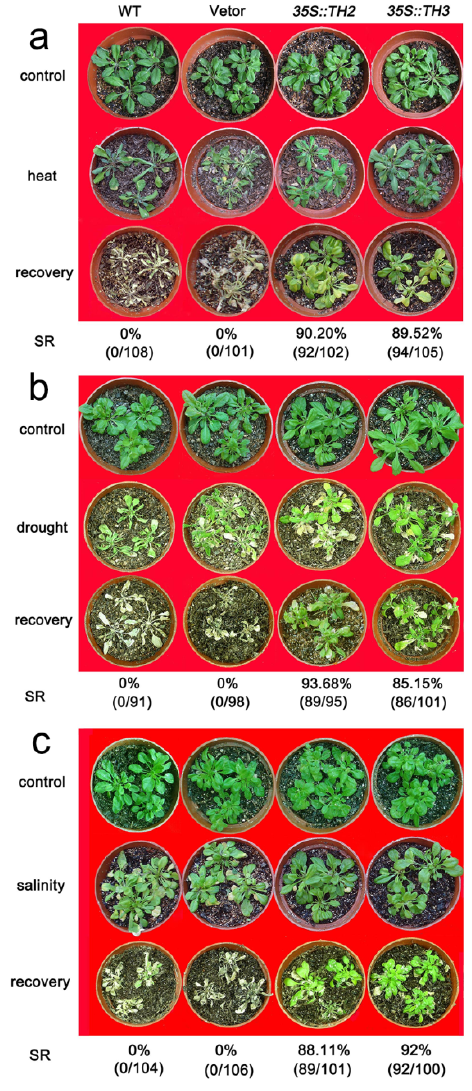
Figure 4. Stress tolerance of A. thaliana plants expressing CgHSP70 . ( a ) The appearance of plants after exposure to 45 °C for 24 h and their survival rate recorded after a one week recovery period; ( b ) The appearance of plants after exposure to drought stress for 24 days and their survival rate recorded after a one week recovery period; ( c ) The appearance of plants after exposure to salinity stress for 15 days, and their survival rate recorded after a one week recovery